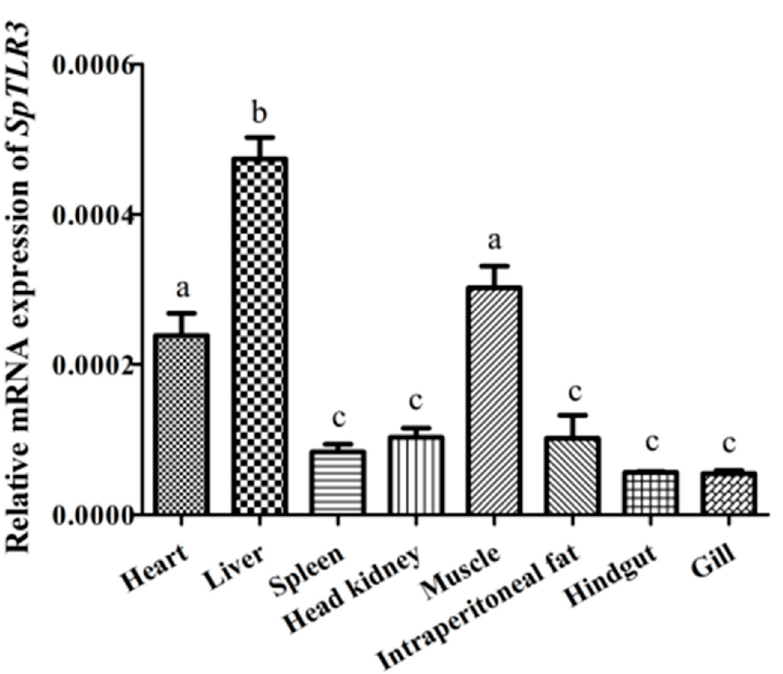
Figure 5. Abundance of SpTLR3 transcripts in heart, liver, spleen, head kidney, muscle, intraperitoneal fat, and intestine of S. prenanti was determined by qRT-PCR. The loading control for normalization was β -actin. The a, b, c means with different letters are significantly different from each other ( p < 0.05). Values are shown as the means ± standard error (n = 4). Error bars, standard error of the means (n = 4 fish per group).